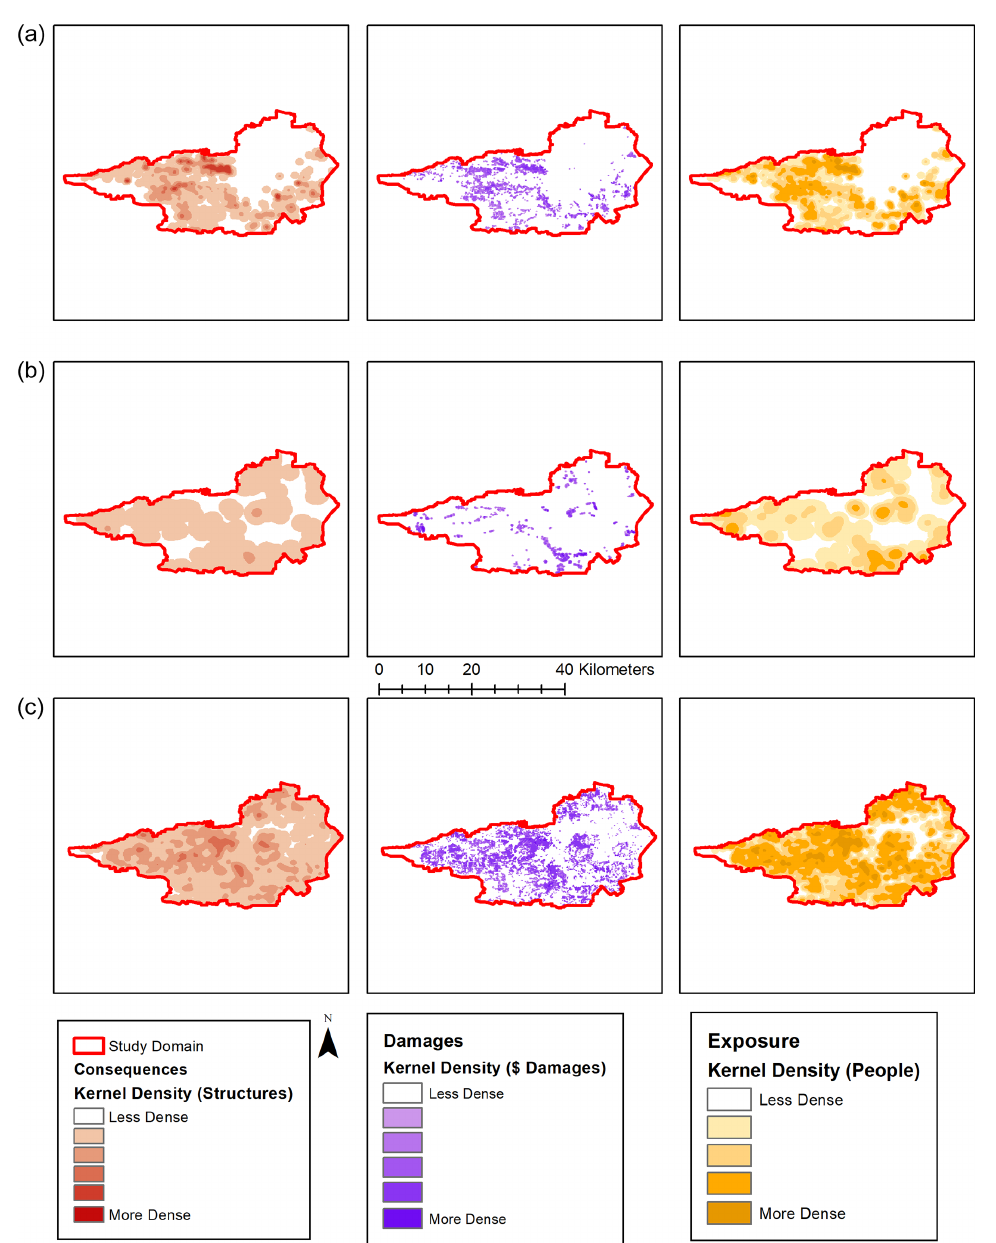
Figure 6. Kernel density maps of NSI buildings, damage, and people per square kilometer impacted by each FIM: (a) HEC-RAS, (b) Au- toRoute, and (c) Fathom-US. The kernel density maps are derived from go-consequences point output for each FIM modeling framework. The dollar symbol denotes US